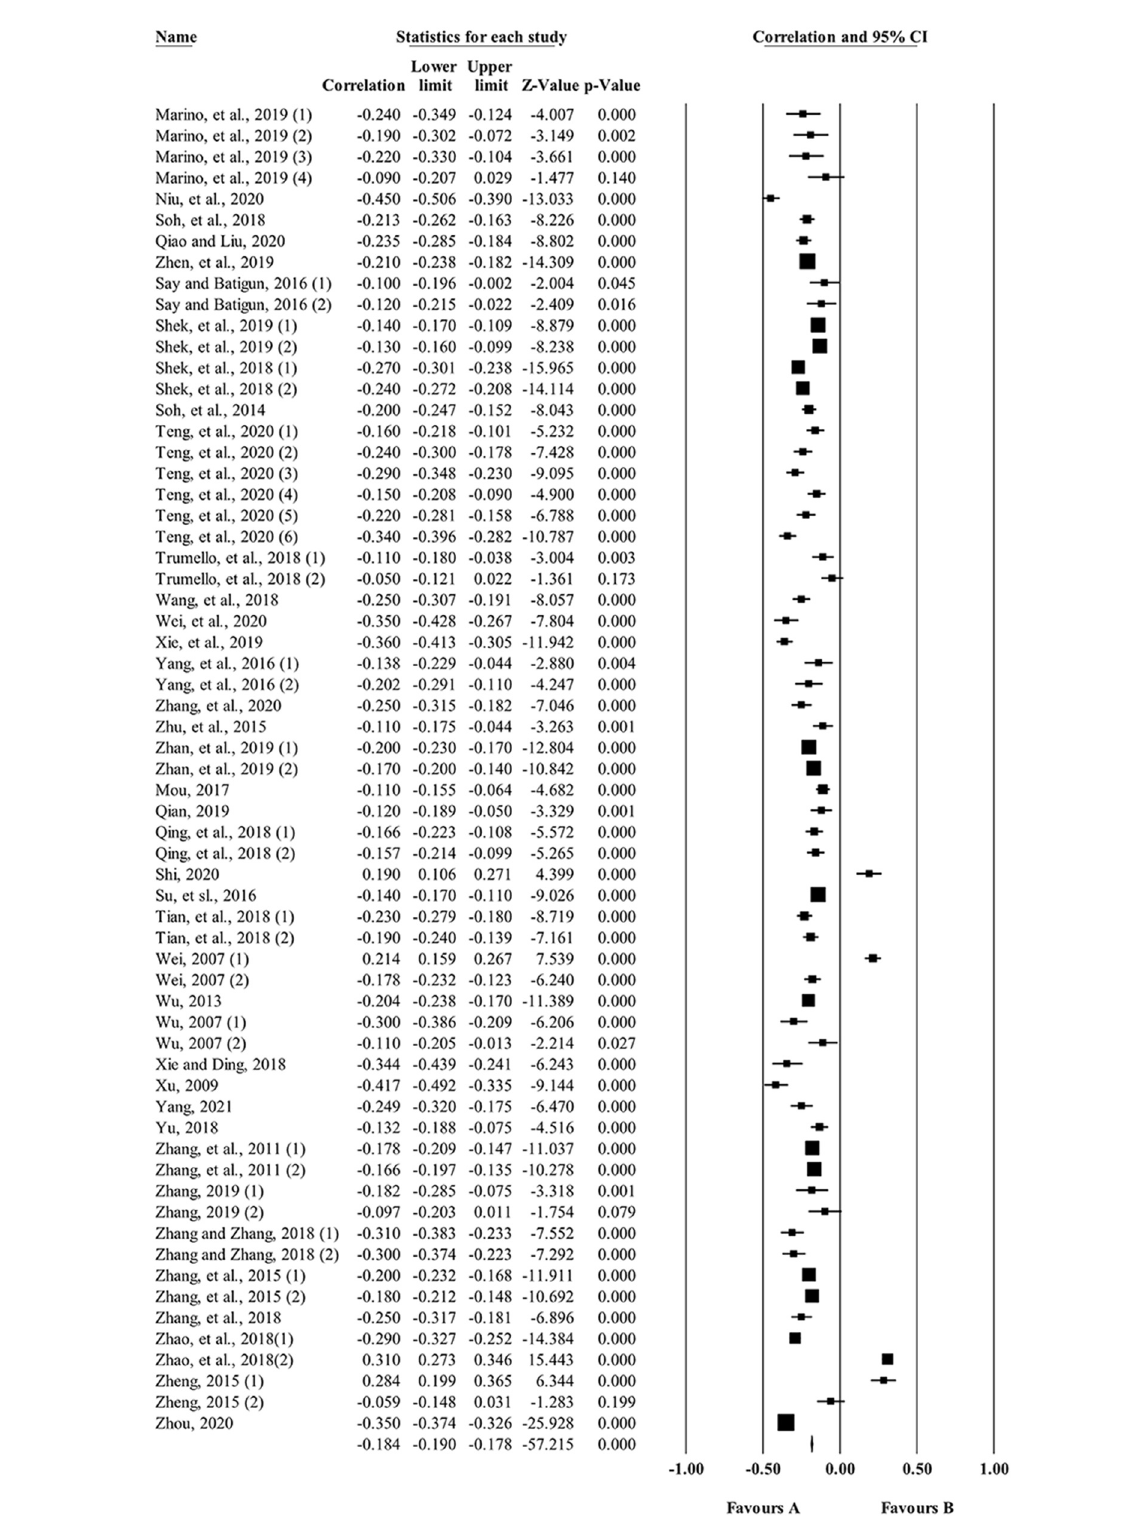
FIGURE2 Forest plot for the link between parent-child relationship and